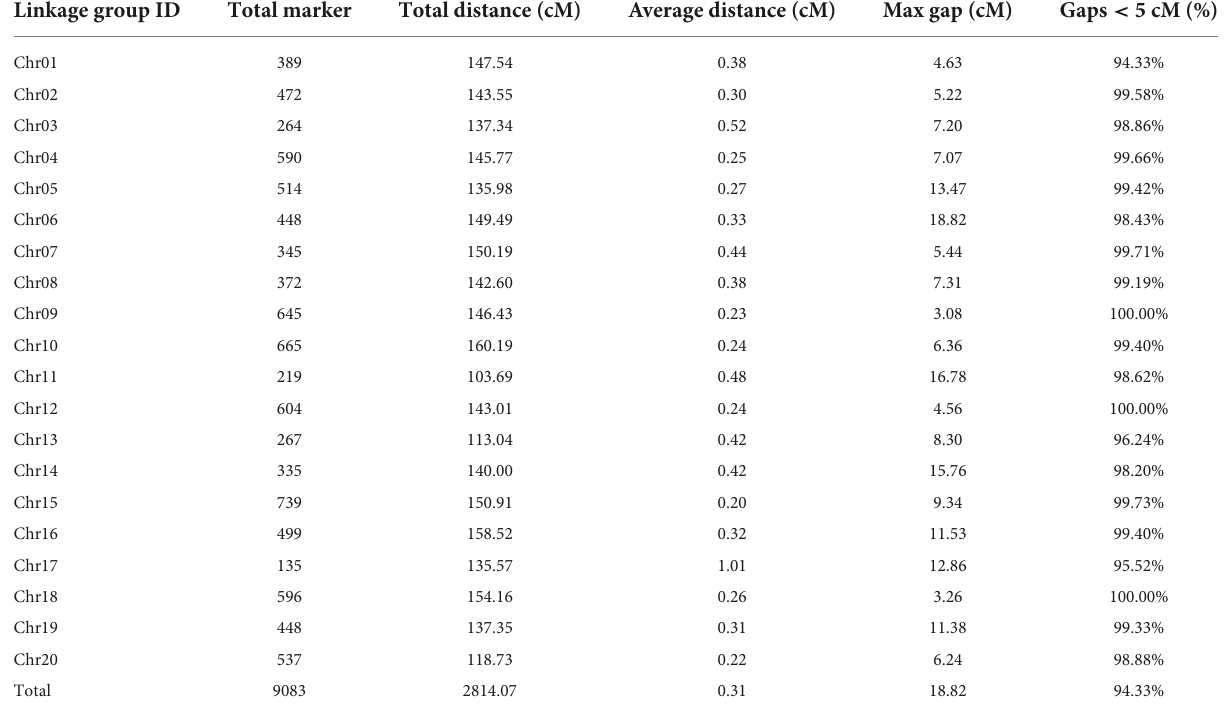
TABLE 1 Characteristics of the high-density genetic